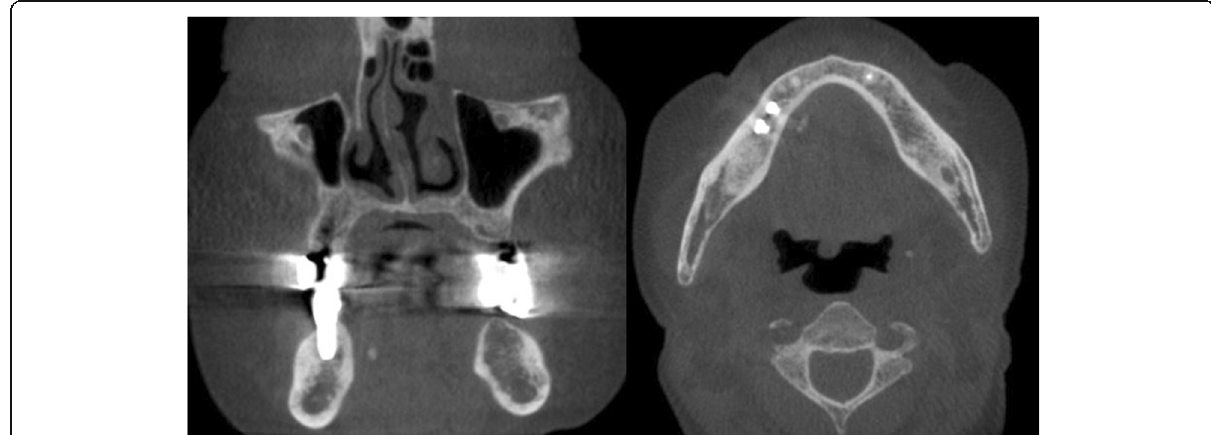
Fig. 1 Salivary stones measuring 2 × 10 mm are detected in the right submandibular gland with cone-beam